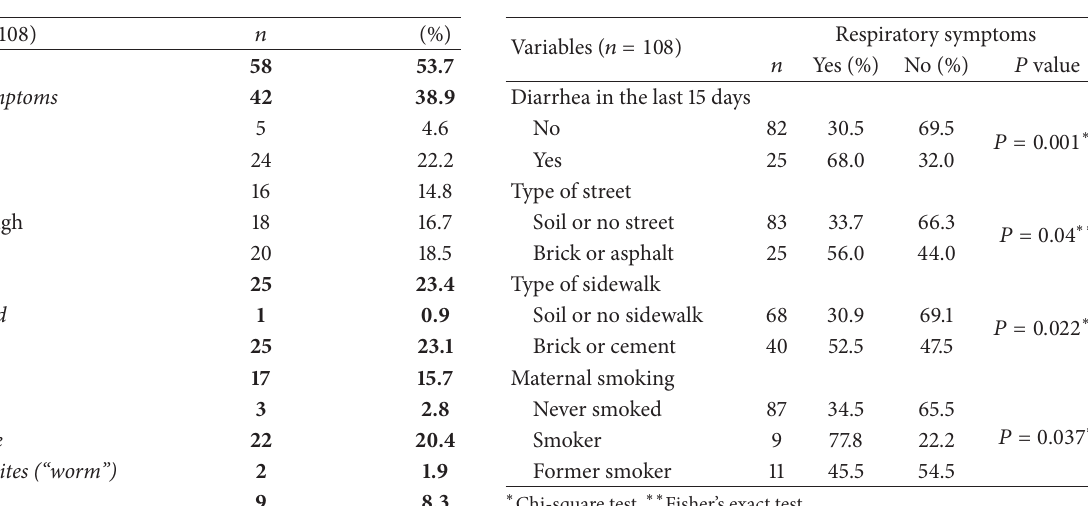
Table 4: Frequency of referred morbidities in the previous 15 days by children under 5 years of age, I˜napari, 2011.